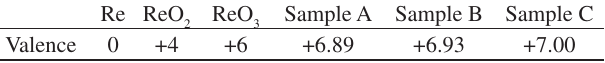
Table 1. Re valence in elementary and Re oxides and in the superconduct- ing samples.